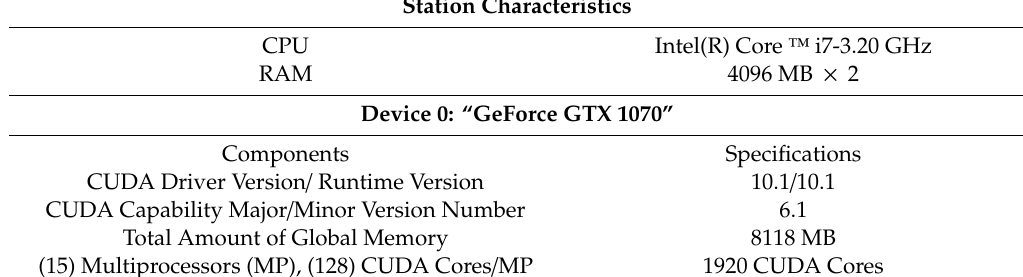
Table 3. Characteristics of the testing environment containing a graphic card “GeForce GTX 1070”.